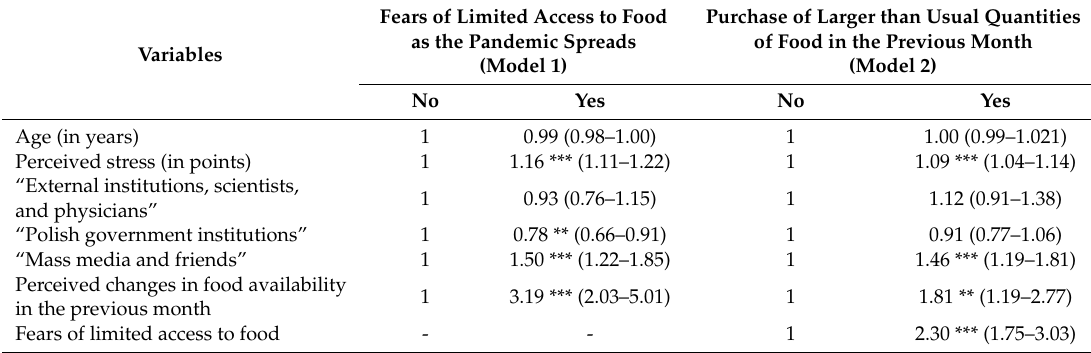
Table 6. Odds ratios (OR; 95% CI) of fears and purchase behaviors of the study